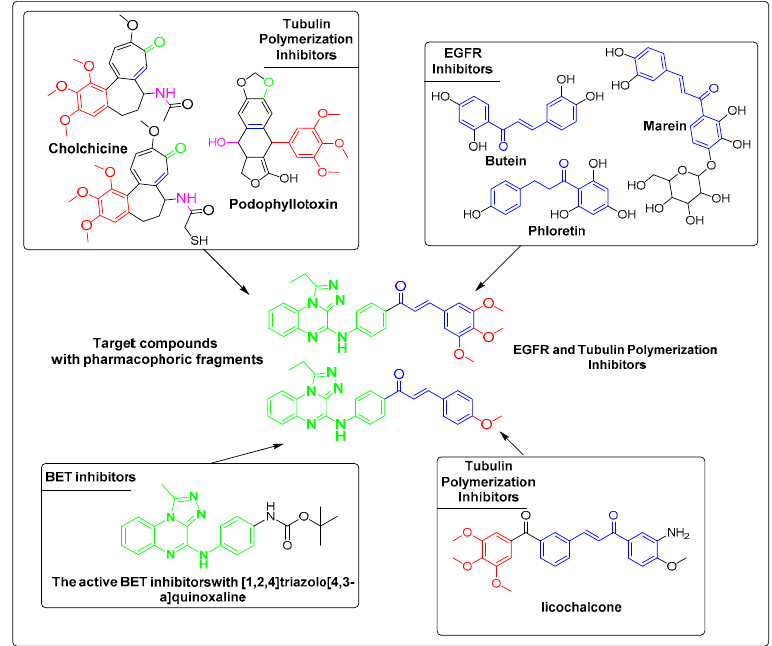
Figure 1. Reference compound sets with different structures and mechanisms. The highlighted substructures reveal the pharmacophore points related to the reported biological effect.